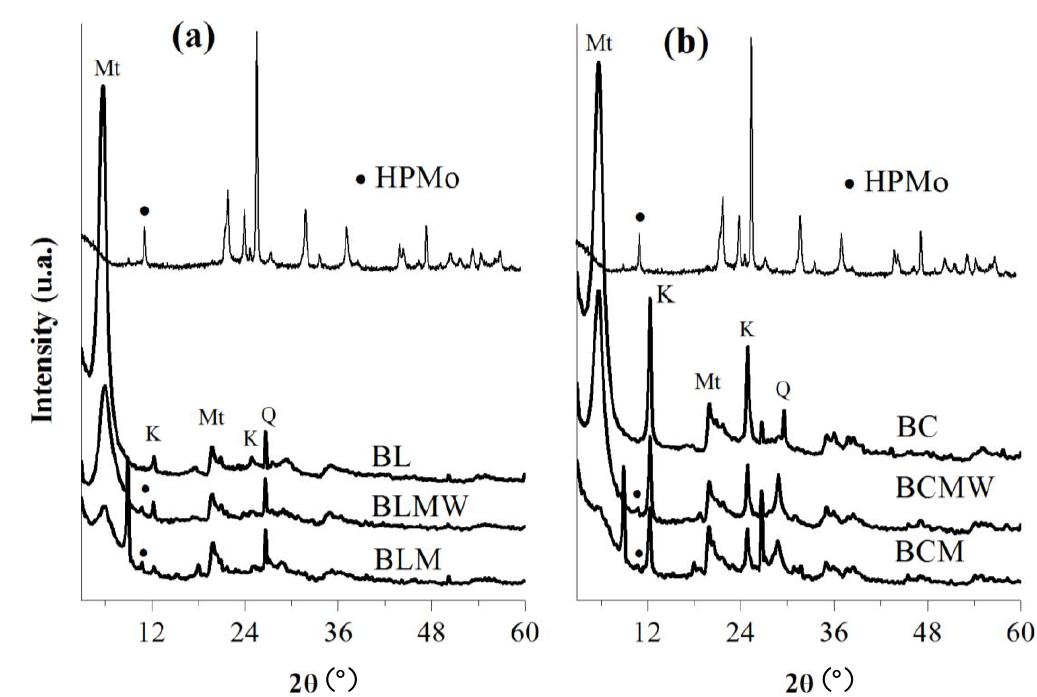
Figure 2. X-ray diffractograms of the samples ( a ) Lagedo Bentonite (BL), Modified Lagedo Bentonite (BLM), Modified Lagedo Bentonite Washed (BLMW) ( b ) Cubati Bentonite (BC), Modified Cubati Bentonite (BCM), Modified Cubati Bentonite Washed (BCMW). The X-ray diffraction (XRD) pattern of HPMo.